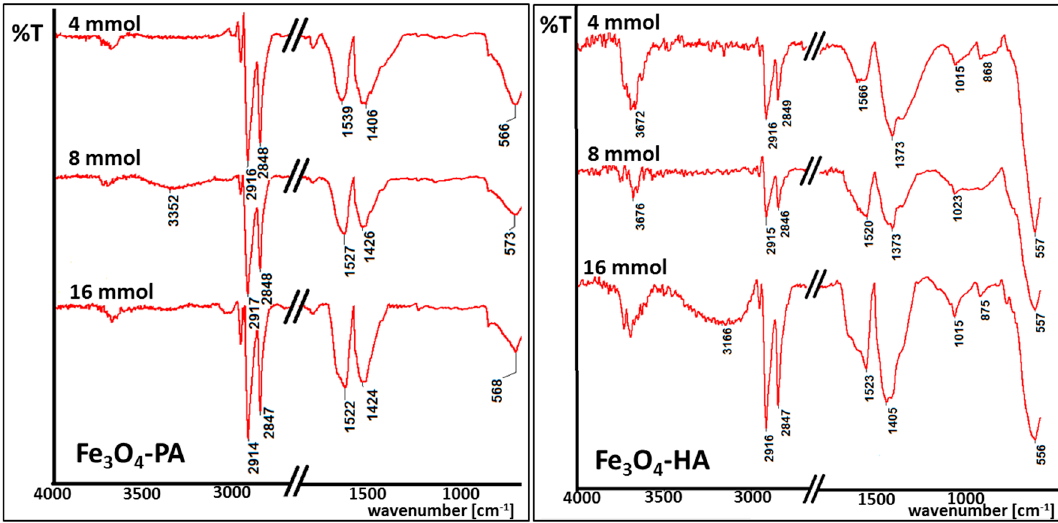
Figure 4. IR spectra of magnetic nanoparticles coated with palmitic acid (Fe 3 O 4 -PA) and hexylamine (Fe 3 O 4 -HA) in tested concentrations.